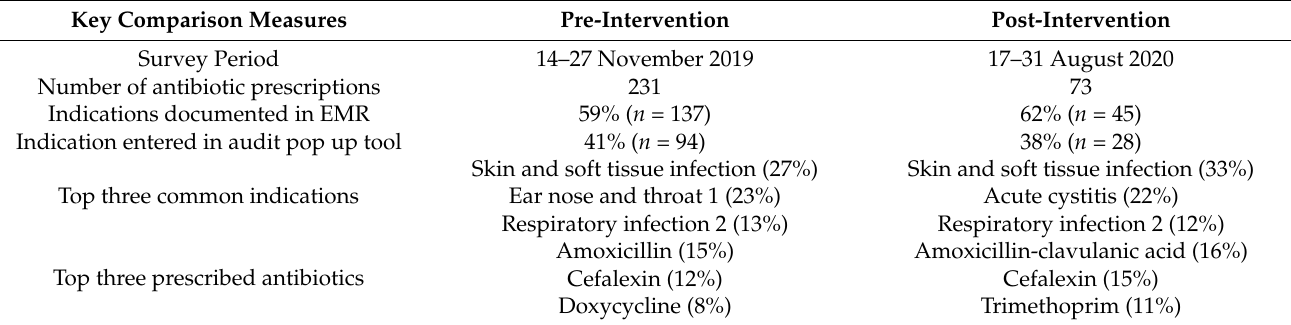
Table 2. Number of antibiotics prescribed, number of indications documented in electronic medical record (EMR), number of indications entered in audit pop up tool, top three common indications, and top three prescribed antibiotics during pre- and post-audit periods from three GP